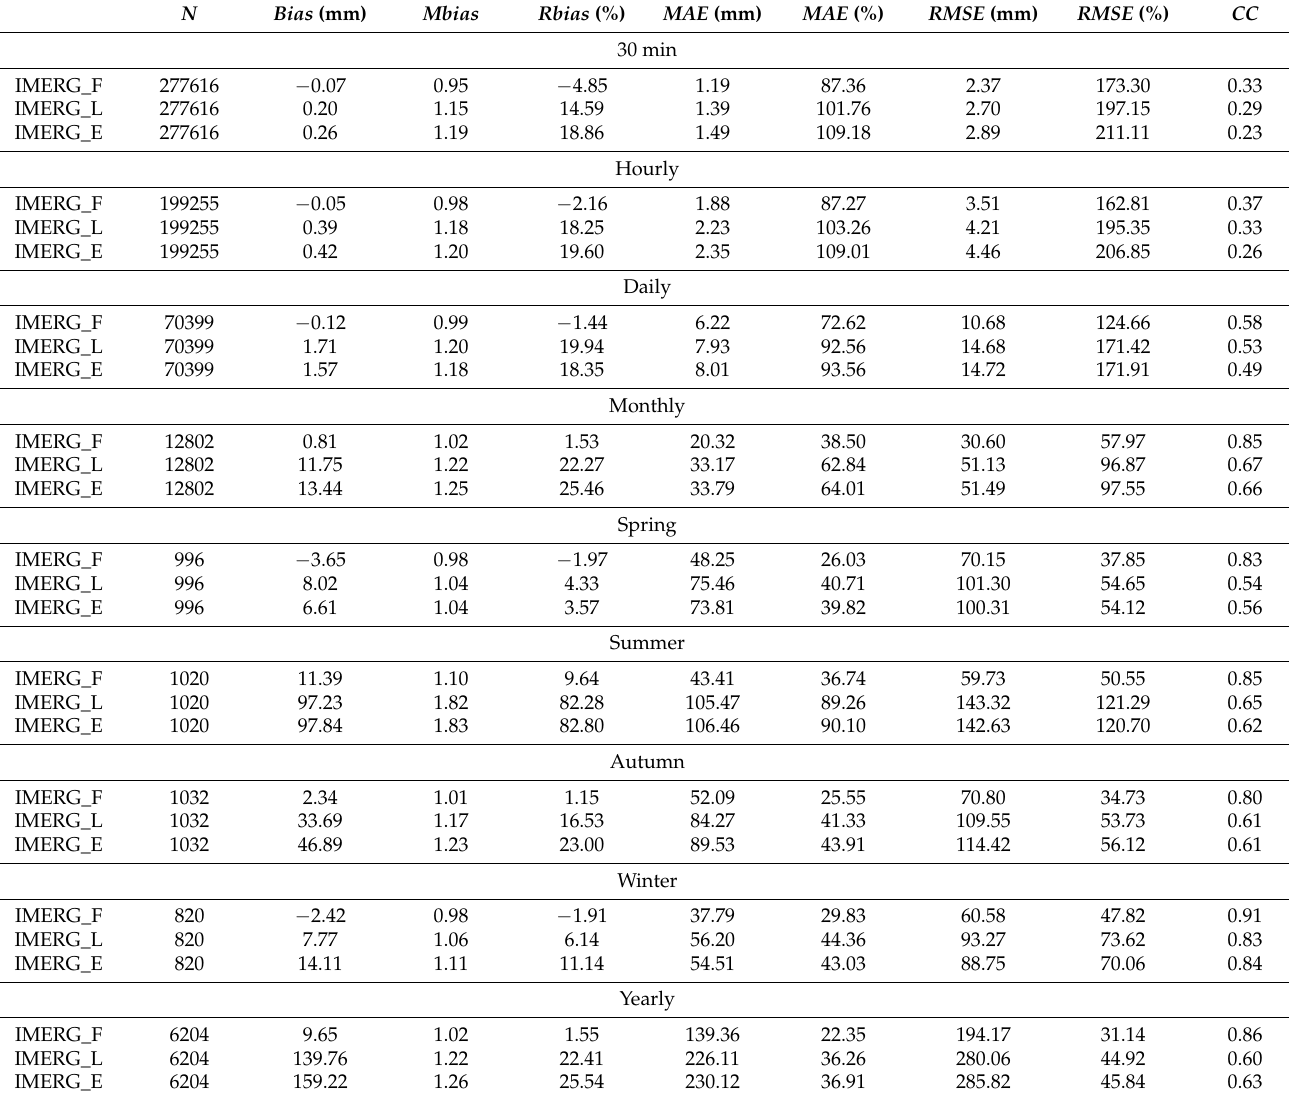
Table 4. Continuous statistics calculated at different scales for the three IMERG